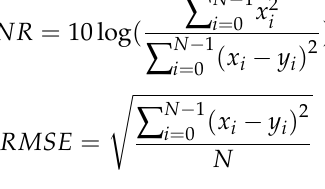
Table 1. Comparison of SNR and RMSE after processing by four methods. Wavelet Decomposition and Reconstruction